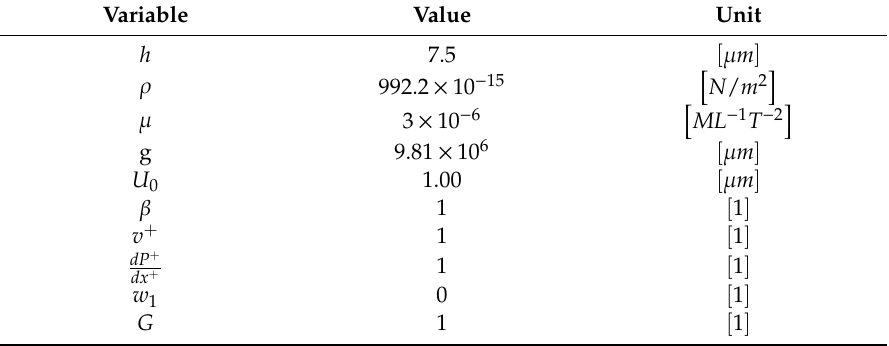
Table 2. Values of variables used in Equation (44) used to plot Figure for each angle